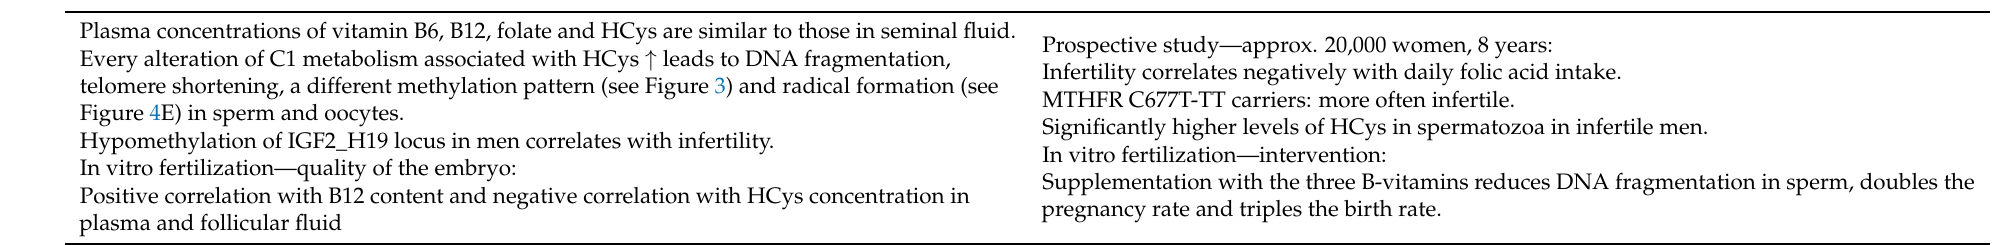
Table A9. Infertility— Rev [201,204].